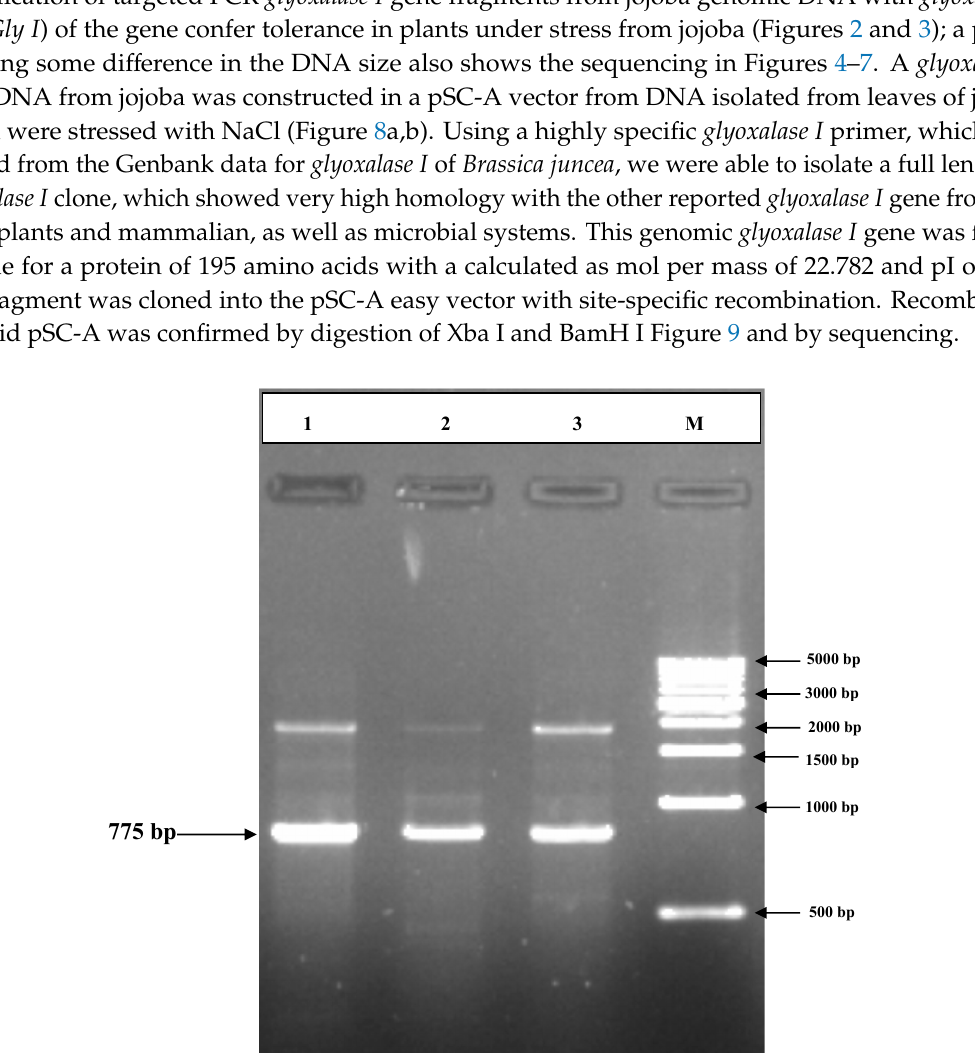
3000 bp 1000 bp